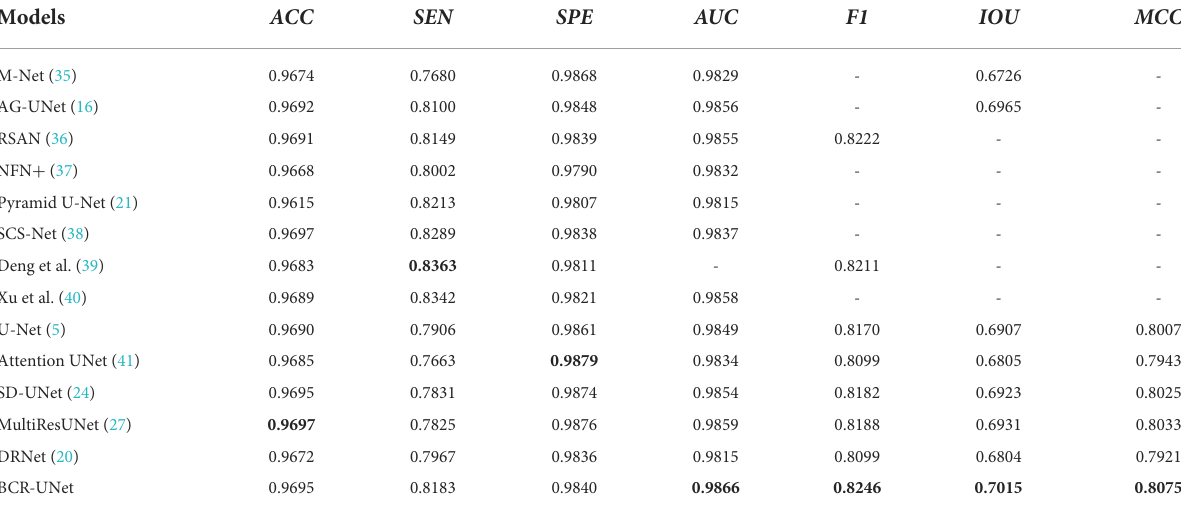
TABLE 5 Results of BCR-UNet and other methods on DRIVE dataset.